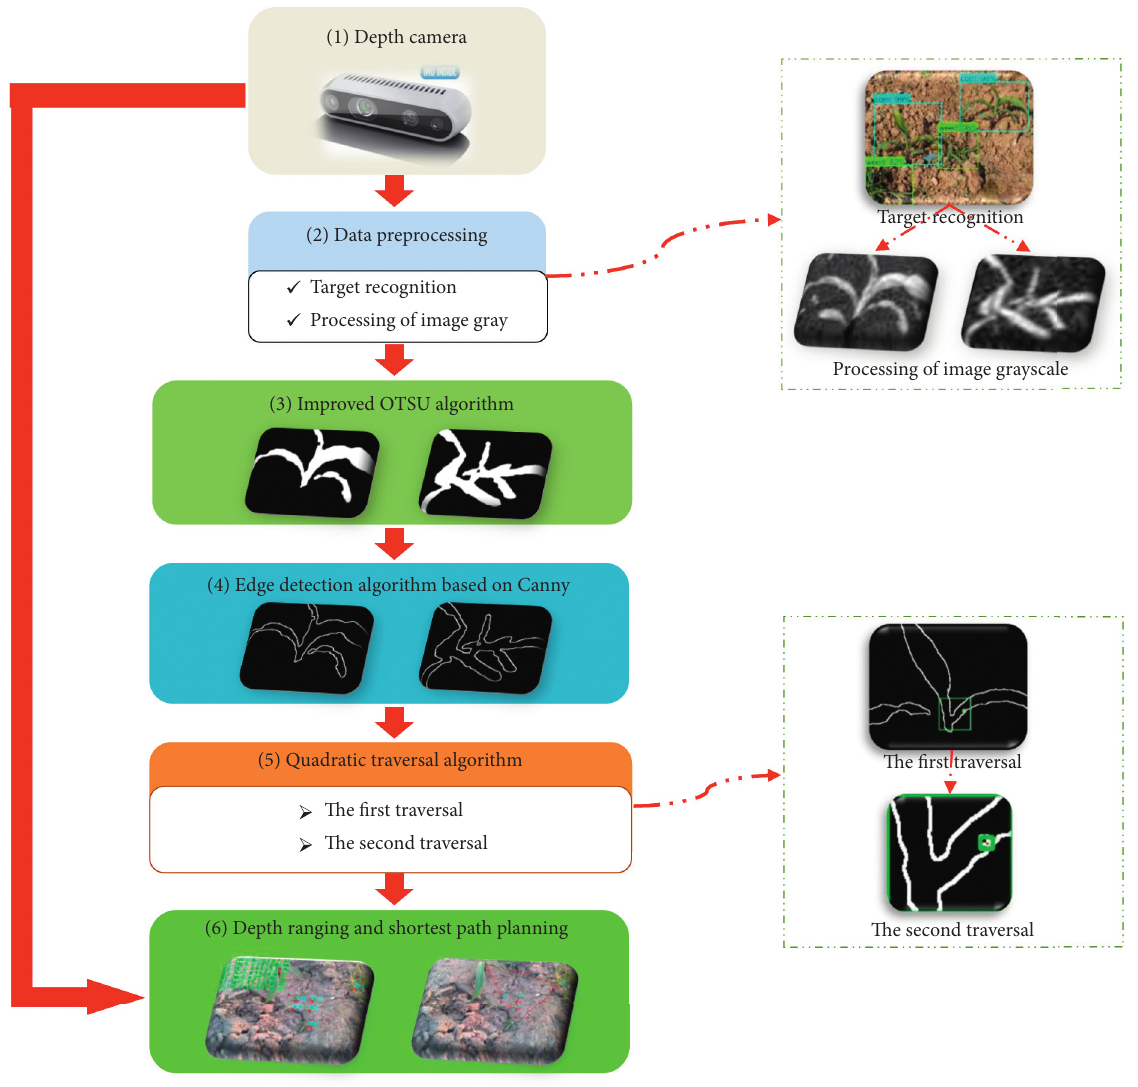
Figure 1: Overview of the system framework. (1) Depth camera is used to obtain real-time image information of cornfield. (2) Data preprocessing is used to complete the preparation of corn and weed images. (3) Improved OTSU algorithm is used to obtain the optimal segmentation threshold for the corn and weed grayscale images. (4) Edge detection based on Canny is used for the contour extraction of corn and weed targets. (5) Quadratic traversal algorithm is used to extract the corresponding 2D coordinate information. (6) Depth ranging and shortest path planning is used to show the experimental effect of our proposed